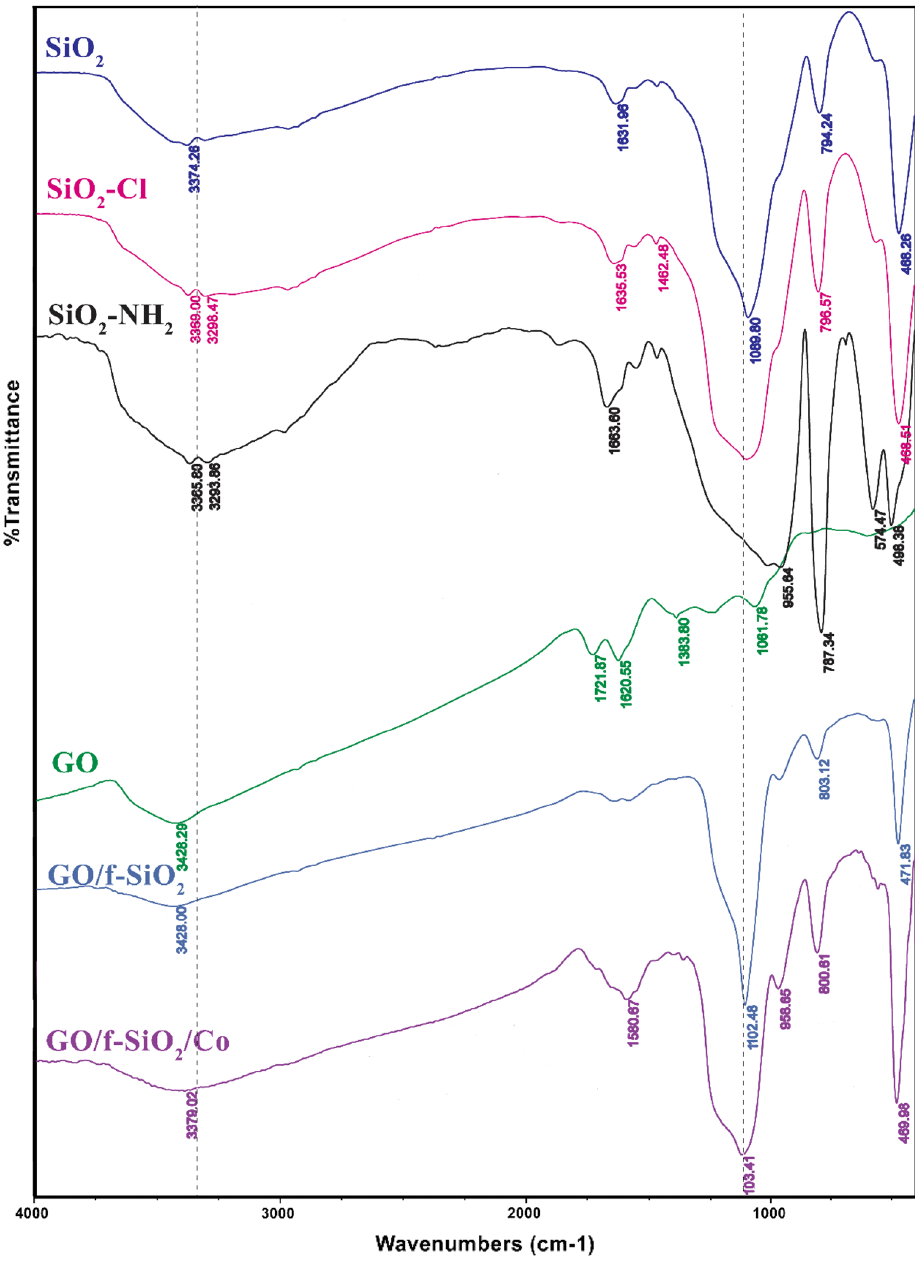
Figure 1. IR spectra for different synthesis parts of the